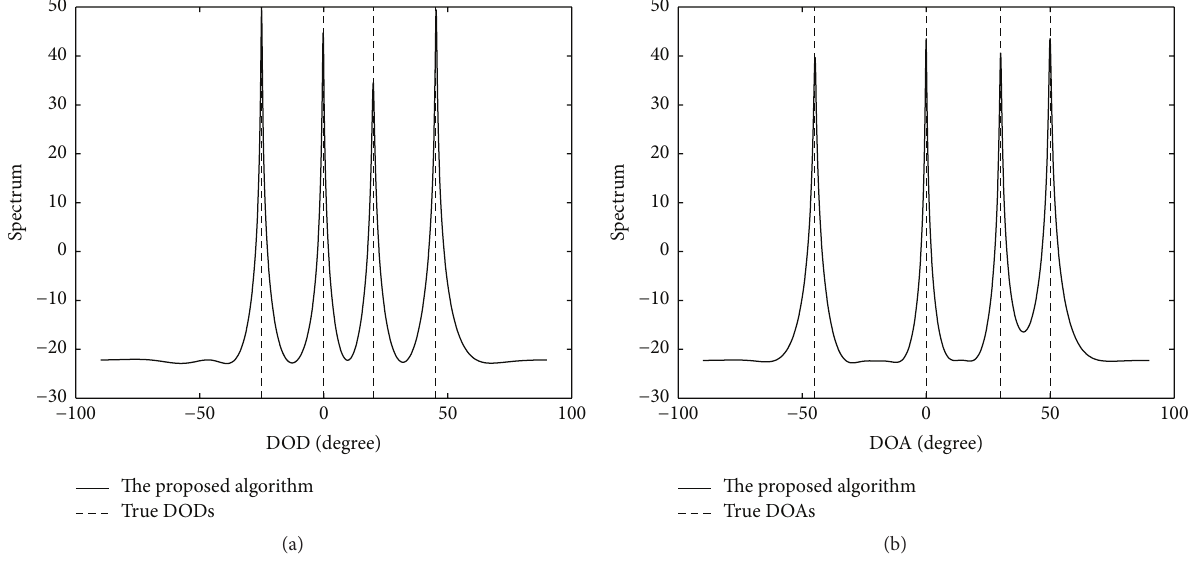
Figure 7: DOD and DOA estimation of multiple coherent targets. (a) DOD and (b)